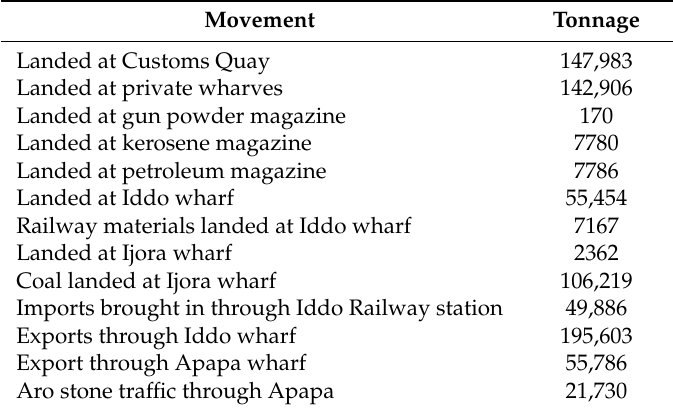
Table 2. Complex movement of goods at Lagos harbour in 1925–1926 [22].